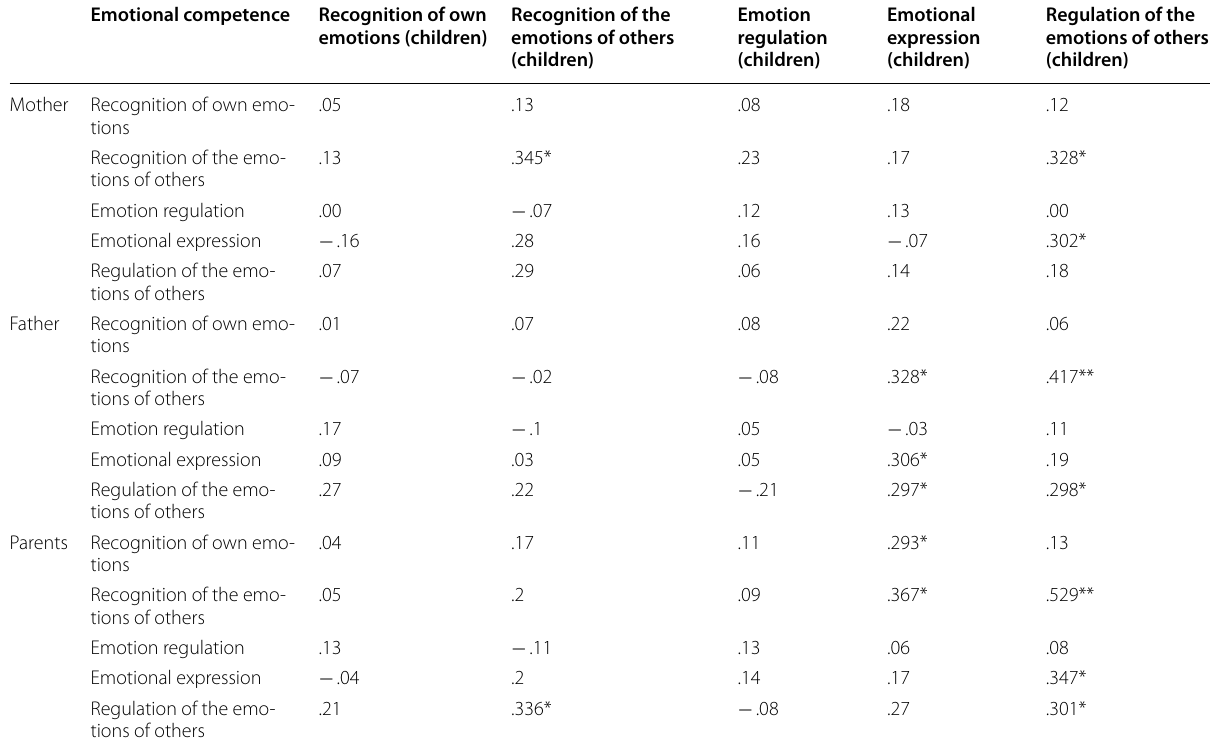
Table 1 Correlation between children’s and father–mother–parents’ emotional competence